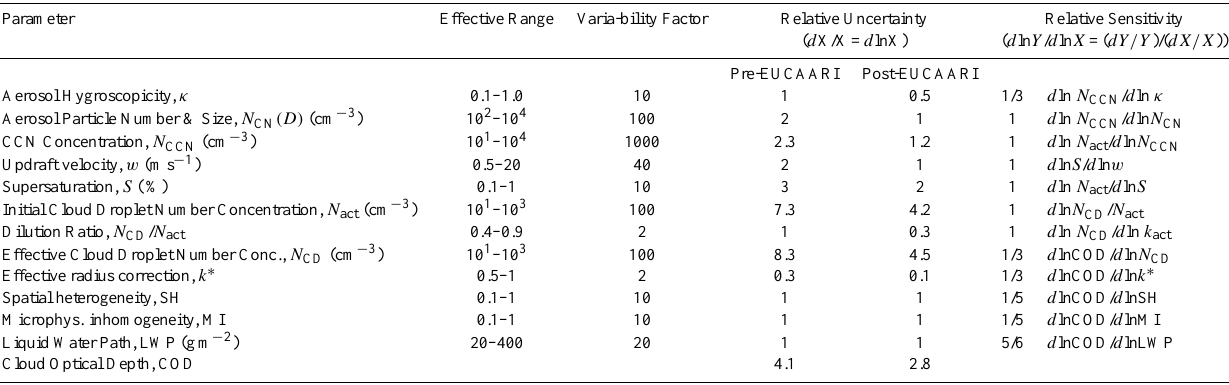
Table 5. Range, variability, uncertainty, and relative sensitivity estimates for major parameters describing the first indirect effect of aerosols on climate (Twomey